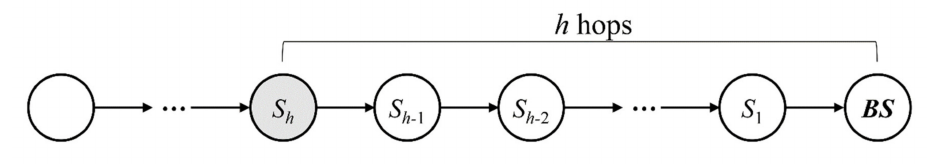
Figure 3. An example of simple topology in wireless sensor networks (WSNs).